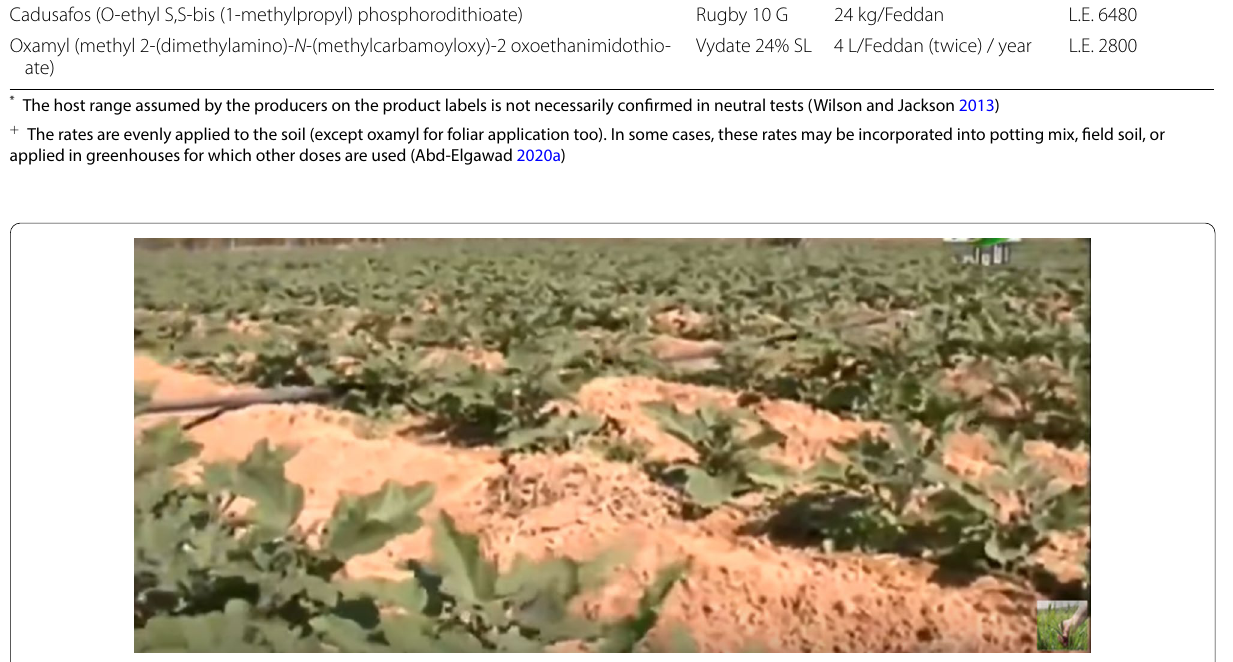
Fig. 1 An Eggplant field showing patchy area due to root‑knot nematode ( Meloidogyne spp.)